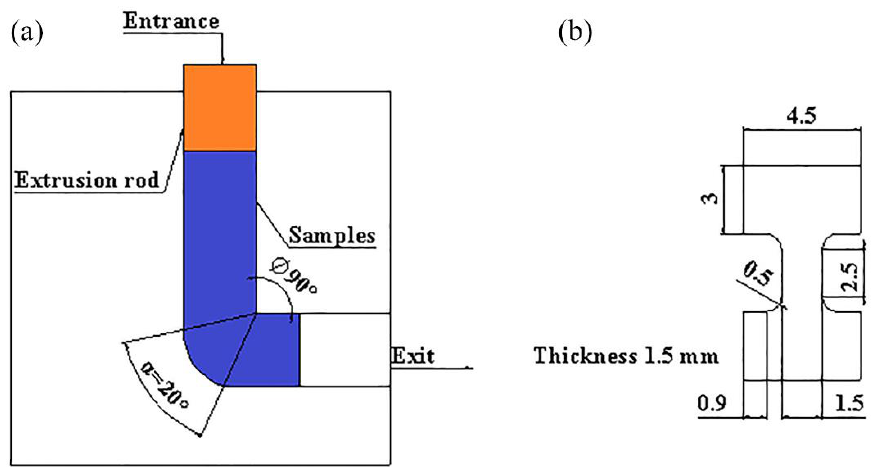
Figure 1. Schematic illustration of the extrusion mold and the tensile samples: ( a ) extrusion mold; ( b ) tensile sample.